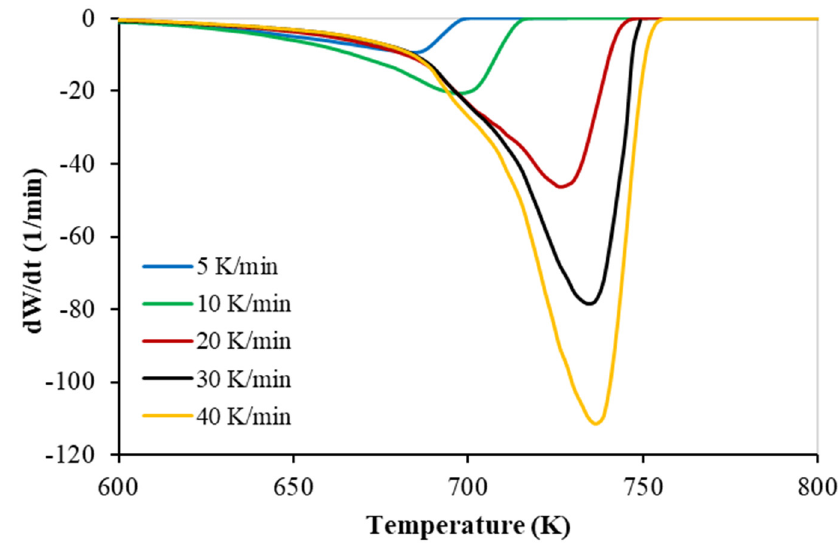
Figure 1. TG curves of PP at different heating rates.